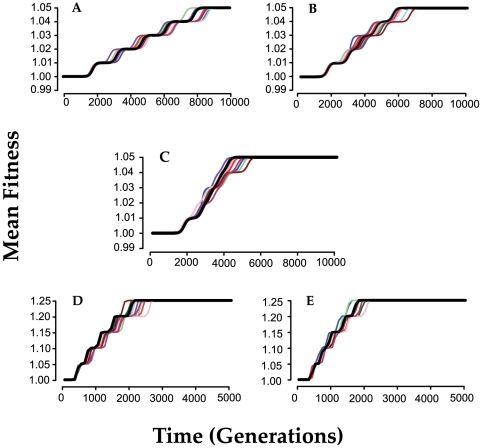
Change in mean fitness with different rates of recombination for ten independent runs initiated with a population monomorphic for the 2,2,2,2,2 genotype.Parameters, N = 108, μ = 10−8, xm1 = 0.80, xm2 = 0.15, xm3 = 0.05, c = 0.90 in (a), (b), and (c) and c = 0.50 in (d) and (e) the exponent e = 1. (a) No recombination, (b) χ = 10−15, (c) χ = 10−14, (d) no recombination, (e) χ = 10−15. The thick dark line in these figures is the mean of the 10 runs.